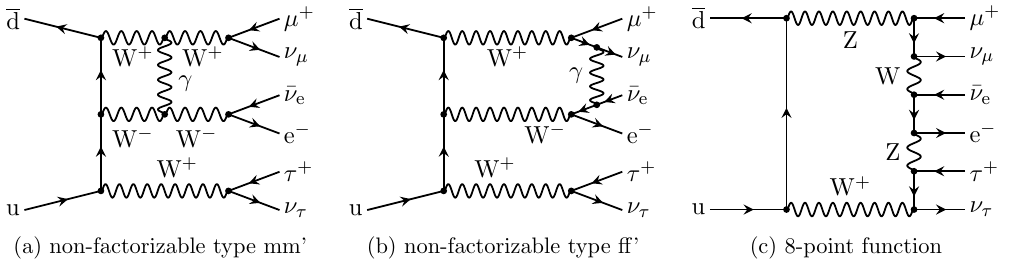
Figure 4. Examples of virtual NLO EW Feynman diagrams contributing to pp ! e (cid:0) (cid:22) (cid:23) e (cid:22) + (cid:23) (cid:22) (cid:28) + (cid:23) (cid:28) + X